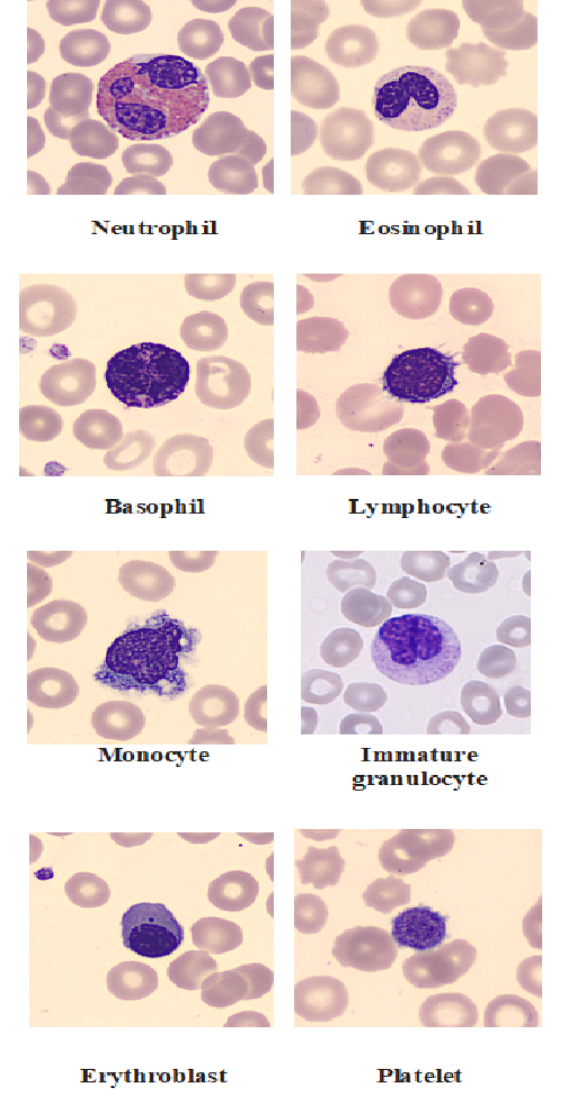
Figure 1. The eight White Blood Cells Types available in the dataset [22]